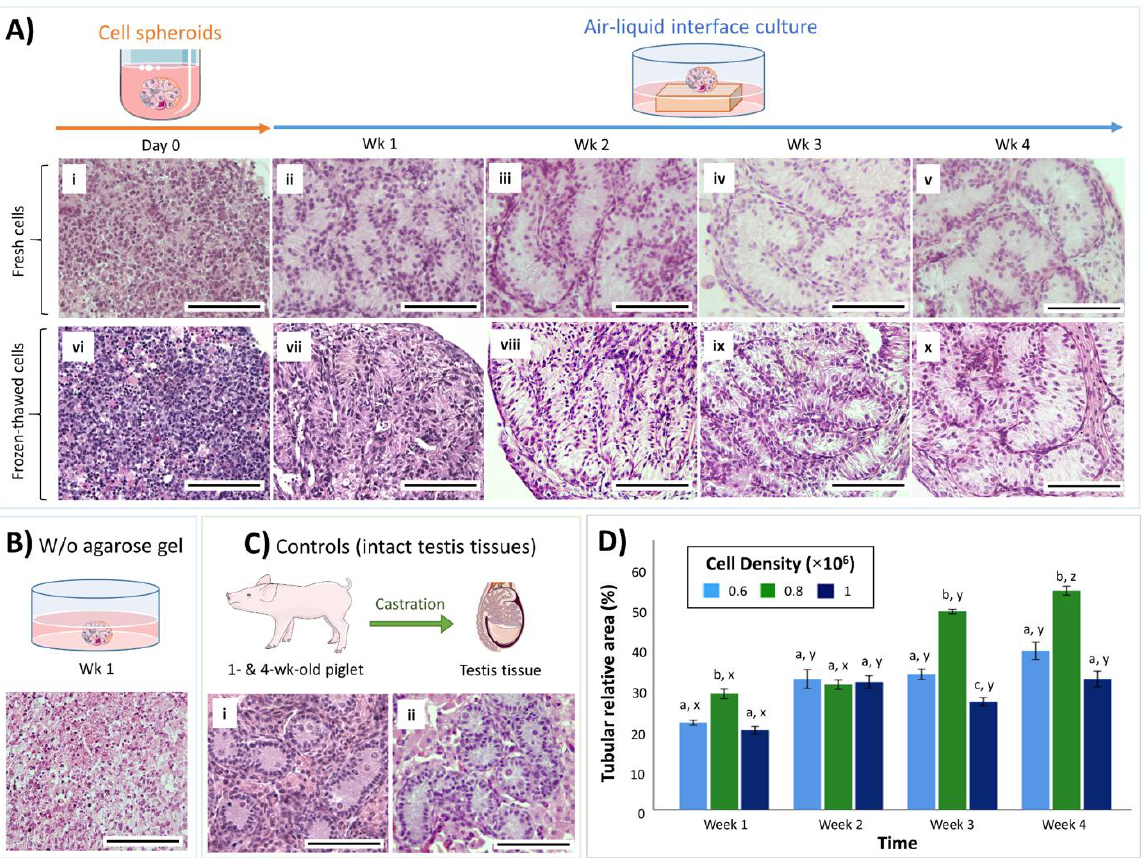
Figure 2. Representative histological micrographs and graphical data summary of tubulogenesis in testis organoids over the period of culture. ( A ) Histological micrographs of cell spheroids and testis organoids formed after culturing of fresh or frozen-thawed piglet testis cells. ( A ( i )) Cell spheroids on day 0 comprised of randomly distributed testis cells without evidence of tubulogenesis. ( B ) Cell spheroids submerged in the culture media (without the support of an agarose base) did not form testis tubular structures after 1 week of culture, and instead most cells underwent apoptosis or necrosis. ( A ( ii – v )) Cell spheroids cultured in the air – liquid interface system showed initial formation of testis tubules at week 1 ( A ( ii )), were further developed at week 2 ( A ( iii )), were maintained to week 3 ( A ( iv )), and week 4 ( A ( v )). ( A ( vi – x )) Frozen-thawed testis cells were also capable of self-assembling to form testis tubular structures that were similar to those of fresh cells. ( C ) Control tissues included intact testis tissues from 1-week-old ( C ( i )) and 4-week-old ( C ( ii )) piglets. W/o: without; Scale bars: 100 µm. ( D ) Tubular relative area (% of cross-sectional tubular area compared with the total area of the histology section) of testis organoids with different cell densities over time. Data are presented as mean ± SEM. abc Data with different letters differ significantly among cell density groups ( p < 0.05). xyz Data with different letters differ significantly over time ( p < 0.05). n = 3 replications.